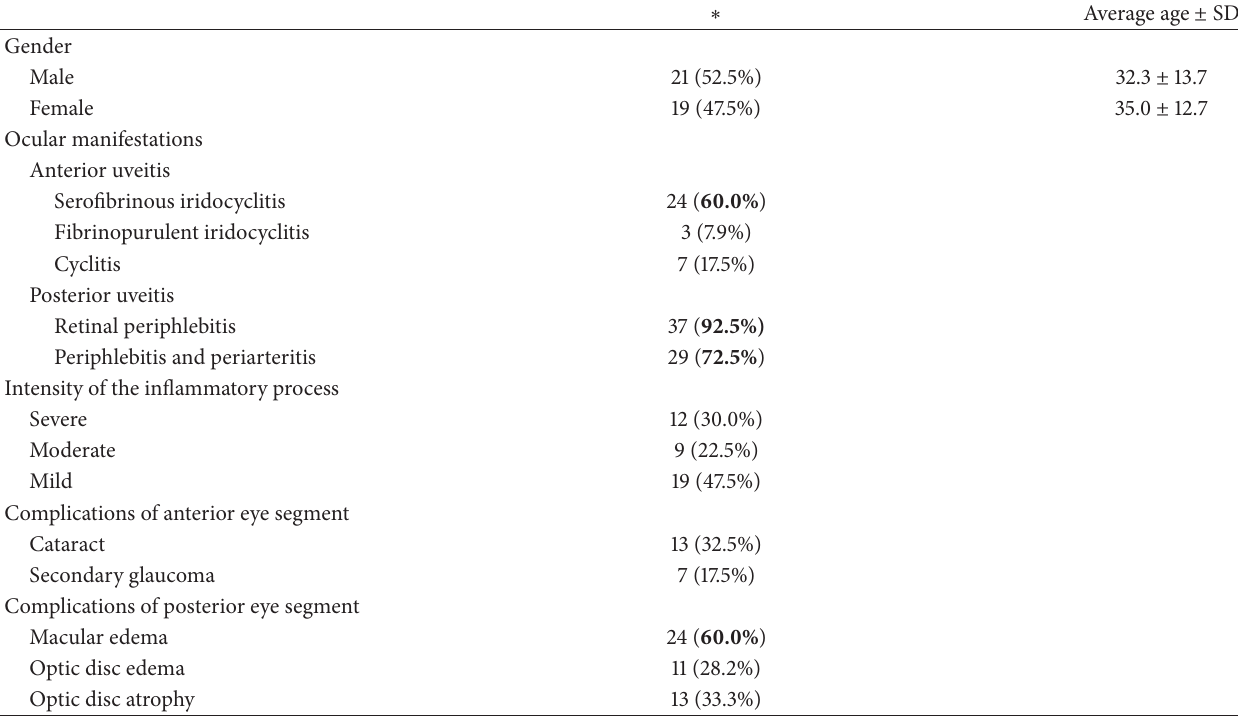
Table 1: Behcet’s disease, ocular manifestations and complications ( 𝑁 = 40 patients).